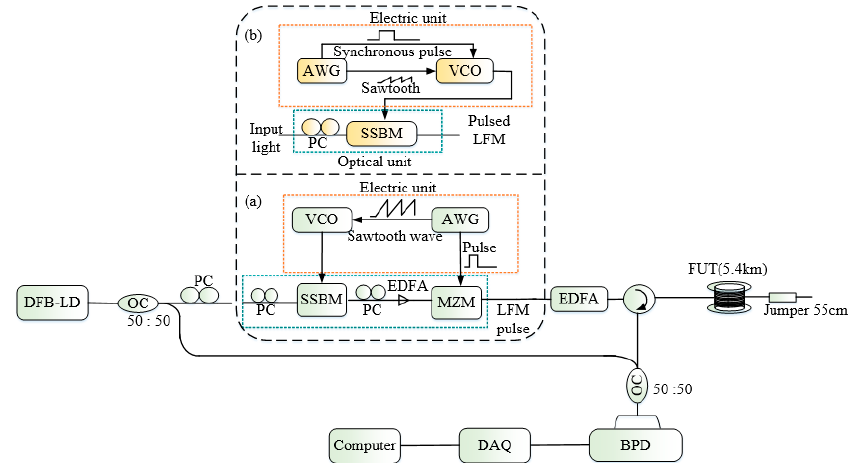
Figure 7. Experimental setup of the pulse-compression Φ -OTDR with ( a ) the primitive scheme for generation of the LFM pulse, ( b ) the improved scheme. SSBM: single sideband modulator, VCO: voltage-controlled oscillator, AWG: arbitrary waveform generator.